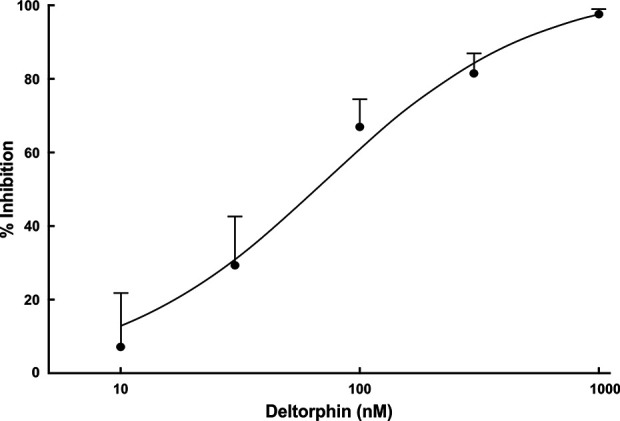
Deltorphin II concentration-response relationship. Sequential application of deltorphin II (10, 30, 100, 300, 1,000 nM) directly to the receptive fields of individual C-fiber nociceptors (n = 4) innervating skin in SNIt animals 28 days after surgery reduced responses to mechanical stimulus (38 mN) in a concentration-dependent manner. Data points represent mean percent inhibition of response in presence of drug, relative to baseline response of each unit ( ± SEM). Estimated EC50 value is 73.5 nM. Regression lines and estimated EC50 value were calculated using STATISTICA 5.5.